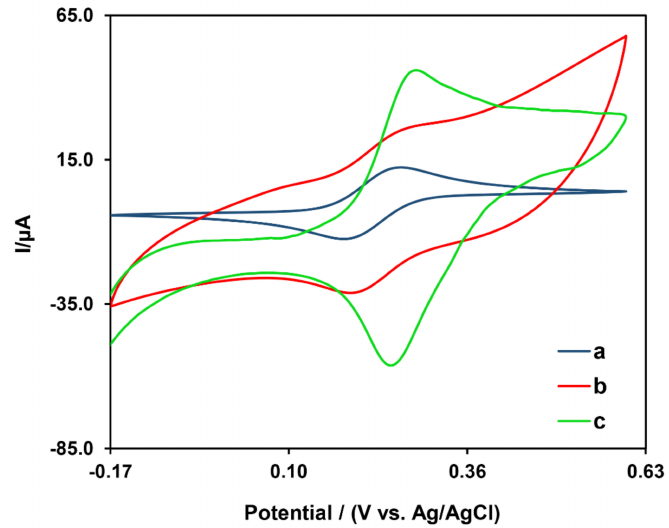
Figure 5. Cyclic voltammetry of bare GCE (a), GCE coated with Fe-Ni@rGO (b), and GCE modified with Fe-Ni@rGO/AuNUs (c) in a solution of 5.0 mM [Fe (CN) 6 ] 3 − /4 − containing 0.1 M